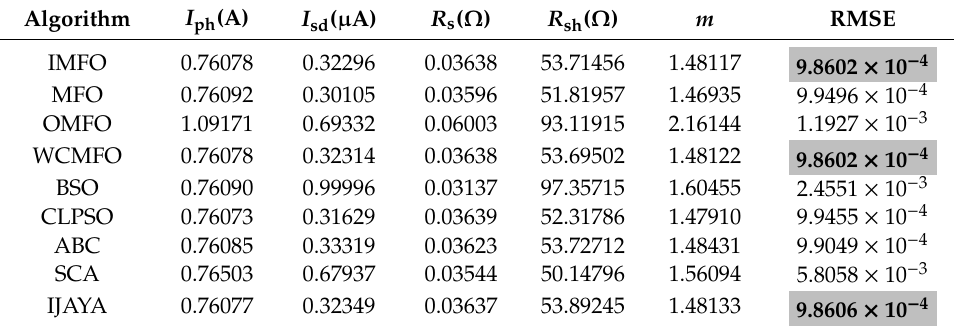
Table 2. Comparison among di ff erent algorithms on the single diode model.